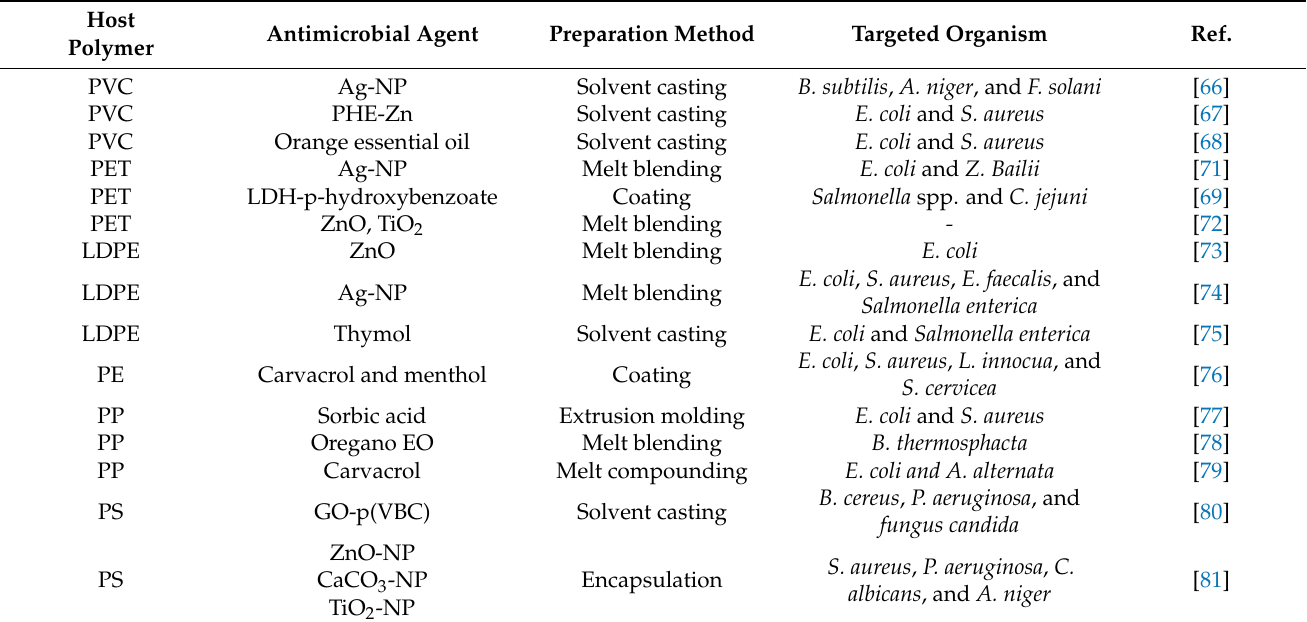
Table 1. Petroleum-based polymers for antimicrobial packaging. Host Antimicrobial Agent Preparation Polymer